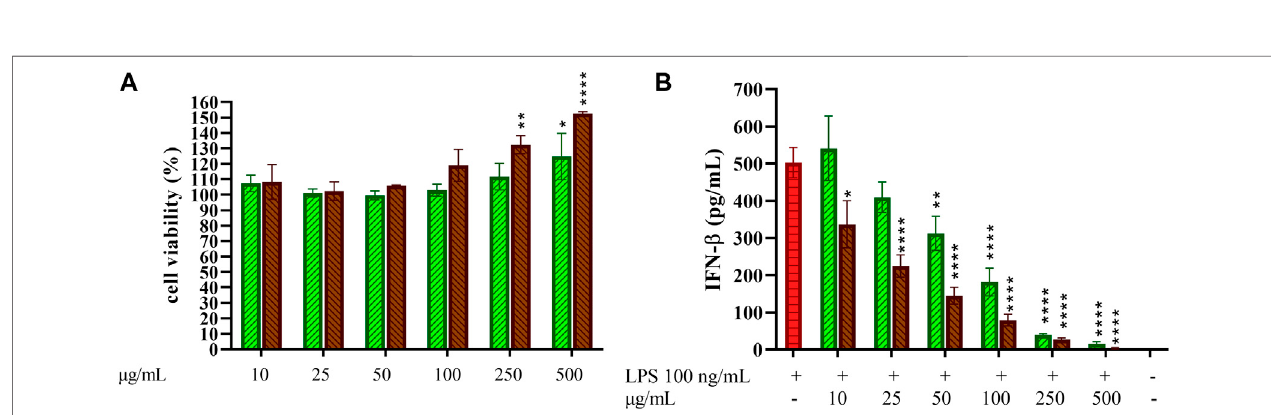
FIGURE 7 | Effect of 5-CQA on CD14+ monocytes-derived macrophages cell viability and IFN- β release. (A) CD14 + monocytes-derived macrophages (MDM) cell viability after treatment with increasing concentrations of GCE ( A , green, down-up diagonal pattern) and RCE ( A , brown, up-down diagonal pattern) was evaluated by MTT assay (24 h). (B) MDM cells were pre-treated with increasing concentrations of GCE (light green, down-up diagonal pattern) and RCE (brown, up-down diagonal pattern) for 1 h and then challenged with 100 ng/ml LPS. Supernatants were collected after 3 h. IFN- β released in the medium was quanti fi ed via ELISA. Data are represented as mean ± SEM of three independent experiments ( n = 3) (one-way ANOVA, * p < 0.05, ** p < 0.01, *** p < 0.001, **** p < 0.0001).